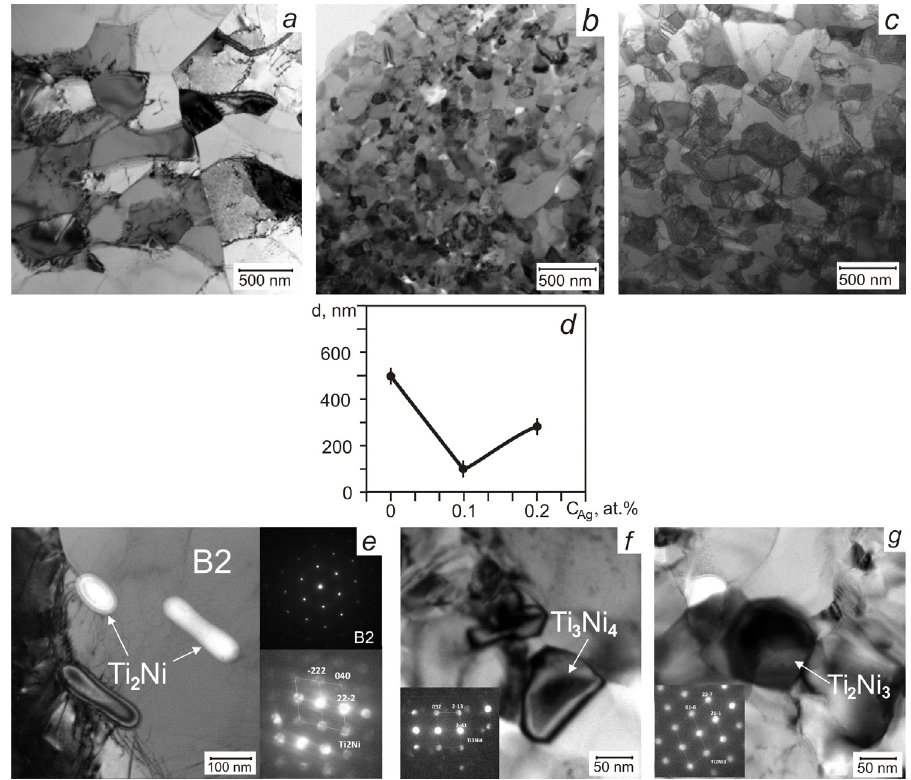
Figure 3. Transmission electron microscopic (TEM) images of TiNi wires with different Ag concentrations: 0 at.% ( a ), 0.1 at.% ( b ), 0.2 at.% ( c ); concentration dependence of the average grain size ( d ); TEM image of the parent and Ti 2 Ni phase, Ti 3 Ni 4 , Ti 2 Ni 3 precipitations with corresponding electron diffraction patterns (EDP) presenting in the studied wires ( e–g ).